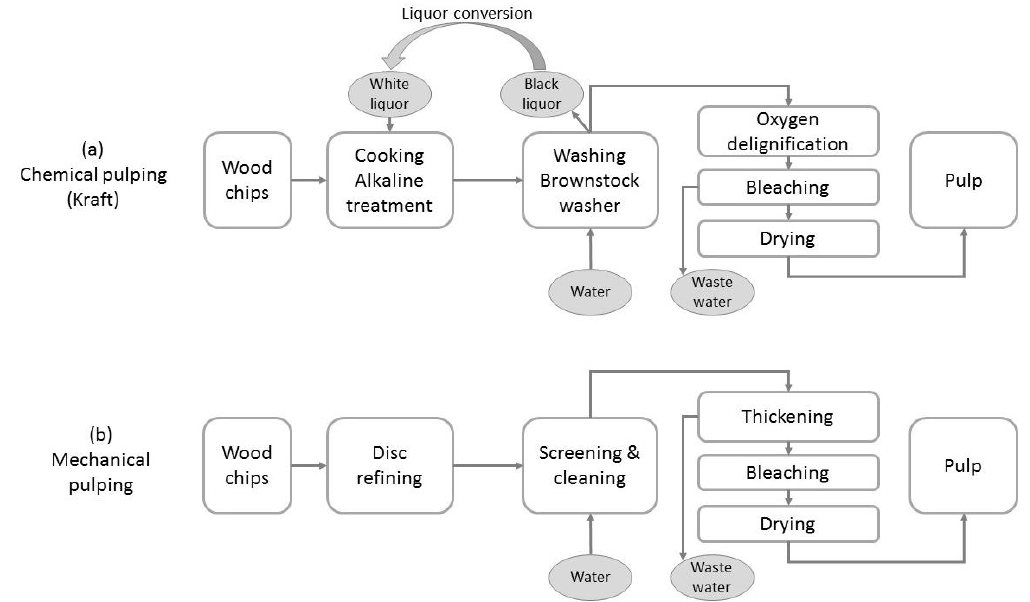
Figure 12. Stages of the pulping process: ( a ) chemical pulping; ( b ) mechanical pulping.